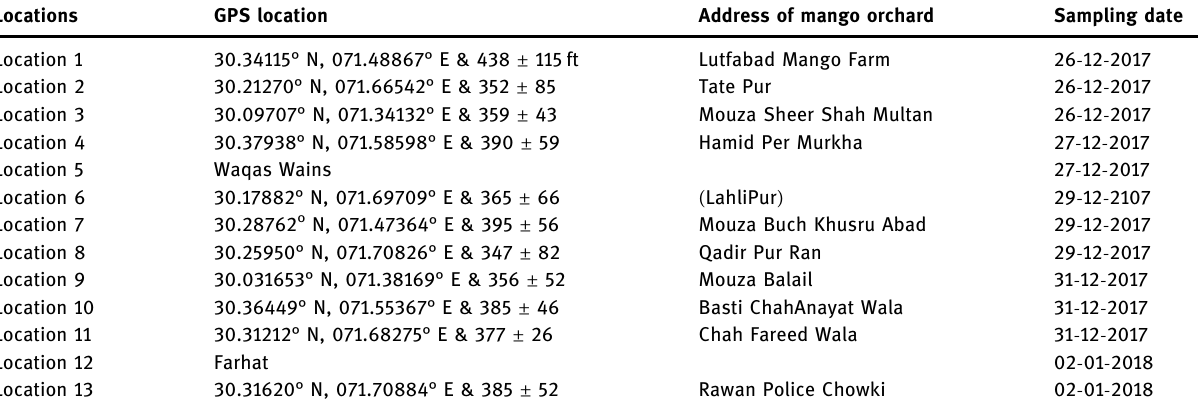
Table 1: GPS location regarding sampling date and data of mango orchards selected for study from Multan region